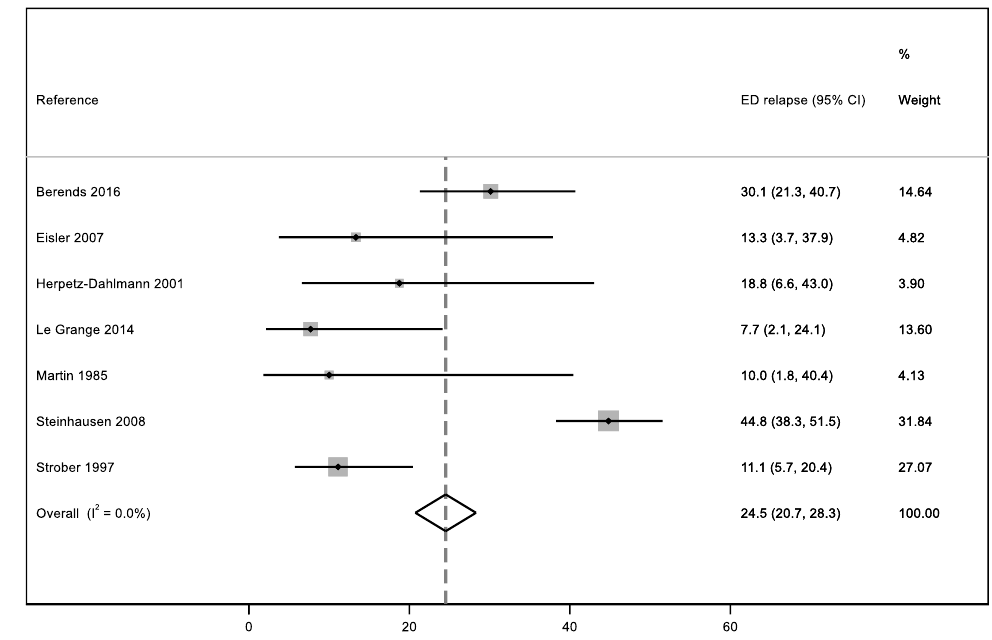
Figure 3. Meta-analysis of ED relapses in early adulthood [40,67,70,72,75 – 77].